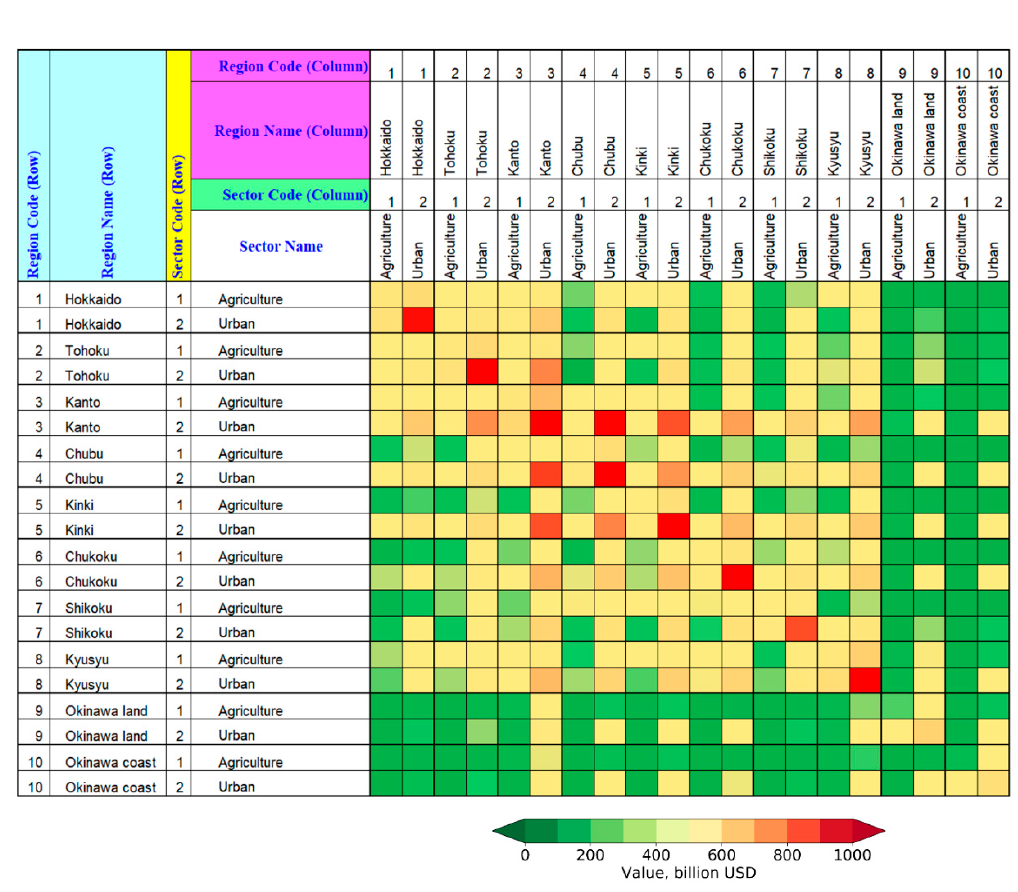
to estimate the tsunami economic losses in the specific area.